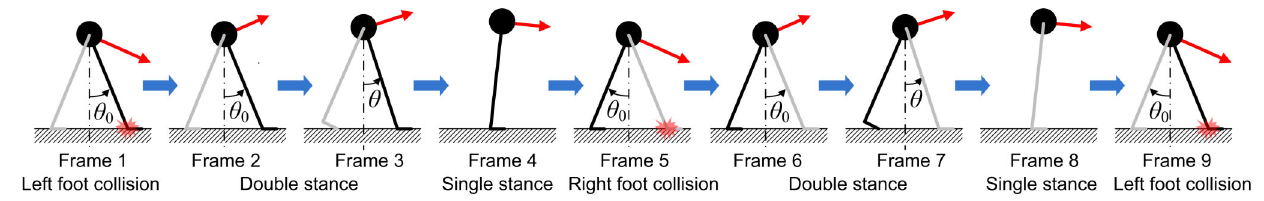
Figure 2. One stride of the walking model. The end and beginning of a step is the moment when the leading foot collides with ground (Frame 1, 5 and 9). During double stance the model moves as four linked bars (Frame 2, 3, 6 and 7). During single stance the model moves as an inverted pendulum (Frame 4 and 8).